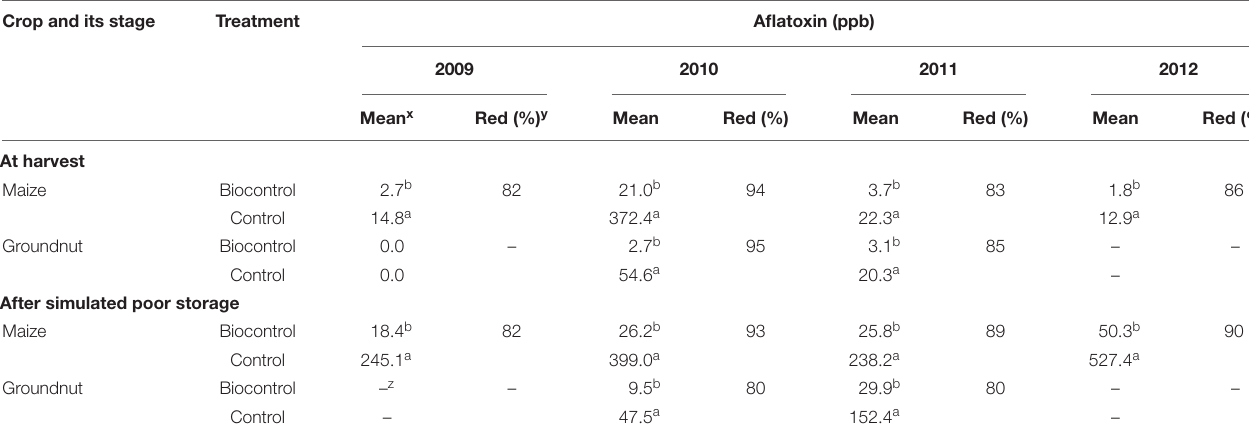
TABLE 6 | Total aflatoxin concentration in freshly harvested and poorly stored maize and groundnut grains from biocontrol-treated and control fields in Nigeria during 2009 to 2012. Crop and its